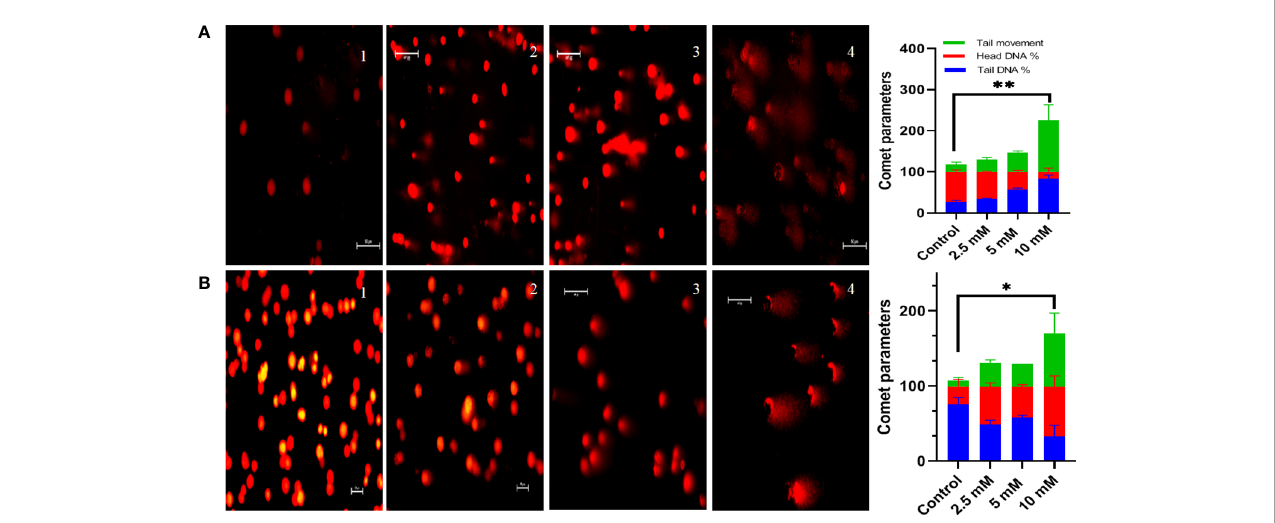
FIGURE 5 Cometassay.CometassaywasperformedtoevaluategenotoxicityinducedbyTMA.CellsweretreatedwithdifferentconcentrationsofTMAfor48h.Representative imagesatX200magni fi cationshowsthatTMAcausesDNAdamageindosedependentmannerasshownin (A) HCT116cellstreatedwithandwithoutTMAand (B) HT29cellstreatedwithandwithoutTMA.1,2,3,and4representcontrol,2.5mM,5mMand10mMtreatmentrespectively.DNAdamagewasenumeratedusingthe OpenCometsoftwaretoolinimageJsoftware(https://imagej.net/software/ fi ji/)asshownin (C) HCT116and (D) HT29respectively.Resultswereplottedascomet parameters.Bothcelllinesshowedsigni fi cantDNAdamageat10mMTMA.Theresults(mean±SEM)wereobtainedfrom3independentexperiments.*indicates